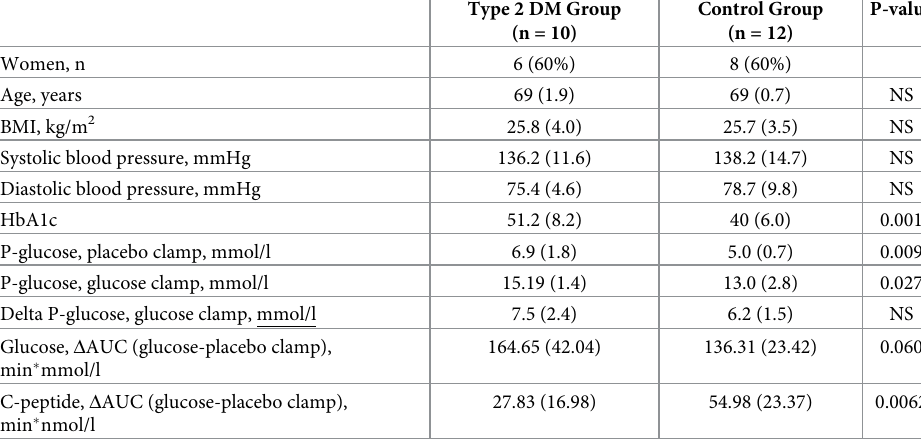
Table 3. Characteristics of the population assessed by neuroimaging.